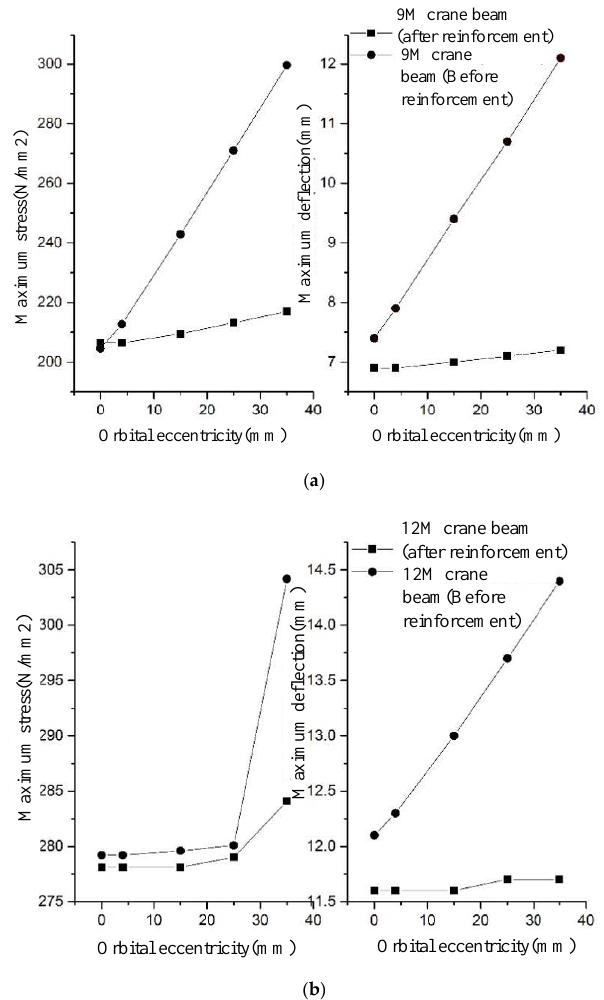
Figure 8. Maximum stress and deflection of crane beam before and after reinforcement. ( a ) The maximum stress and deflection of 9 m crane beam before and after reinforcement; ( b ) the maximum stress and deflection of 12 m crane beam before and after reinforcement.